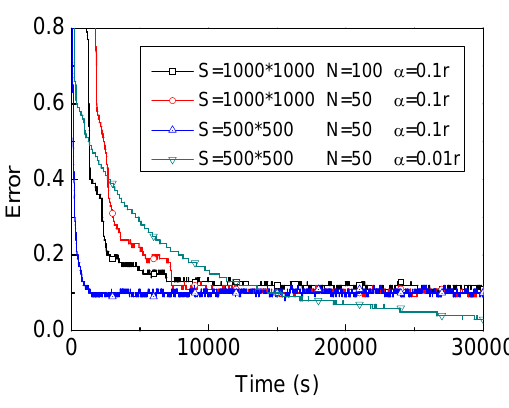
Figure 2. Different exemplars of MBL.